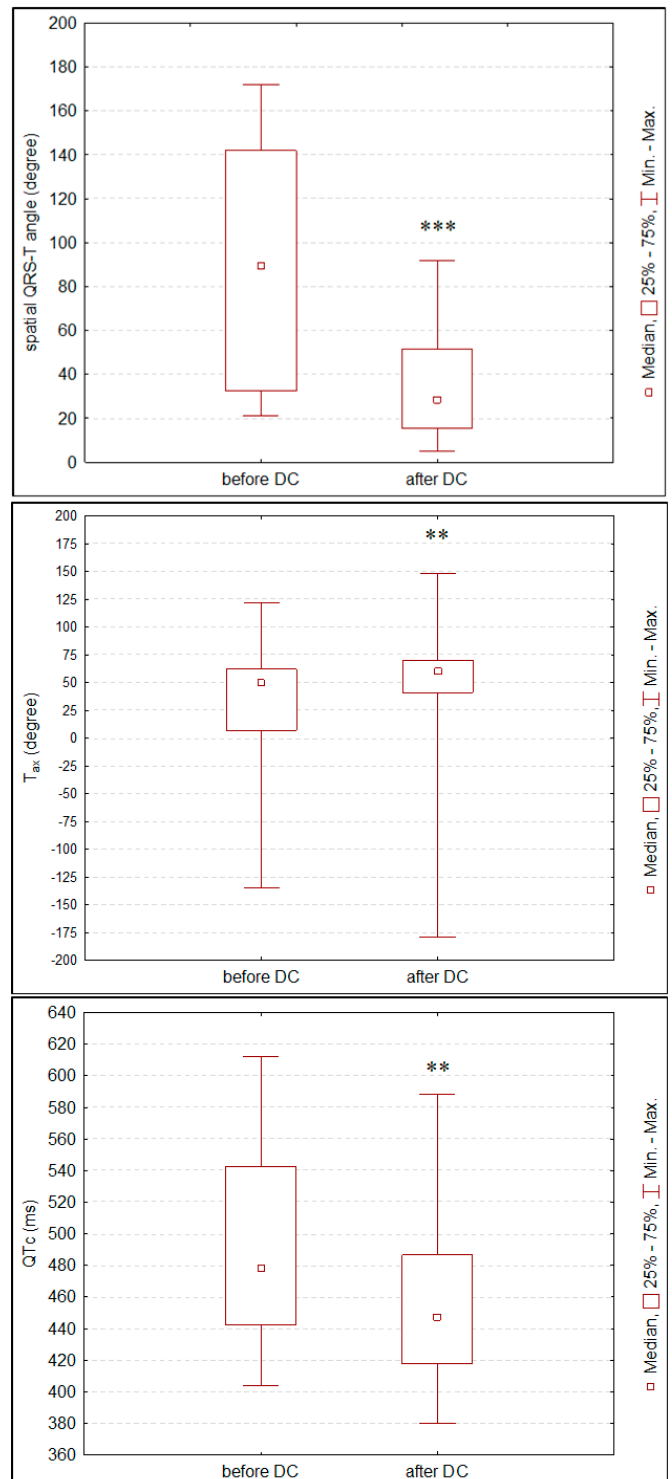
Figure 2. Changes in spatial QRS-T angle, T axis (T ax ) and corrected QT (QTc) interval calculated by Bazett’s formula before and after decompressive craniectomy (DC). Significant decrease was also noted in QTc calculated with Fridericia or Framingham formulas ( p < 0.05). ** p < 0.01, *** p < 0.001—differences between variables before and after DC (Wilcoxon test).